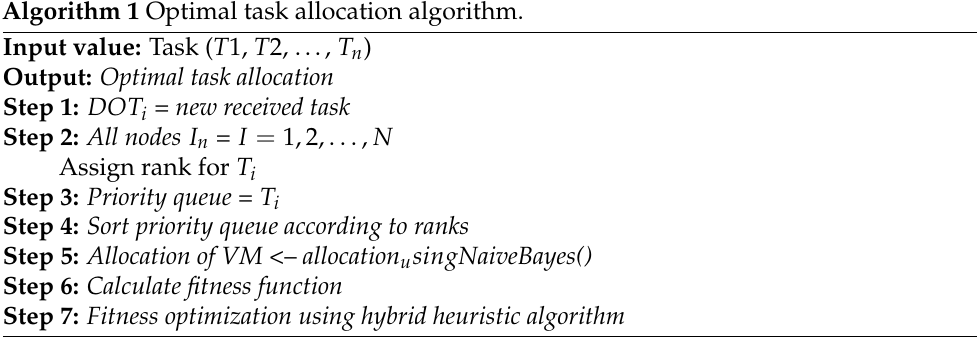
Algorithm 1 Optimal task allocation algorithm.